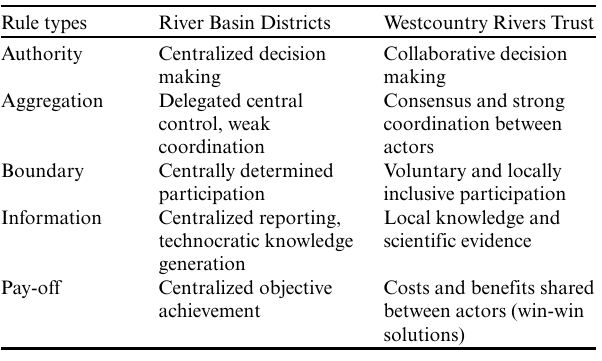
Table 1 . The different institutional features evident in the agency type River Basin Districts and partnership Westcountry Rivers